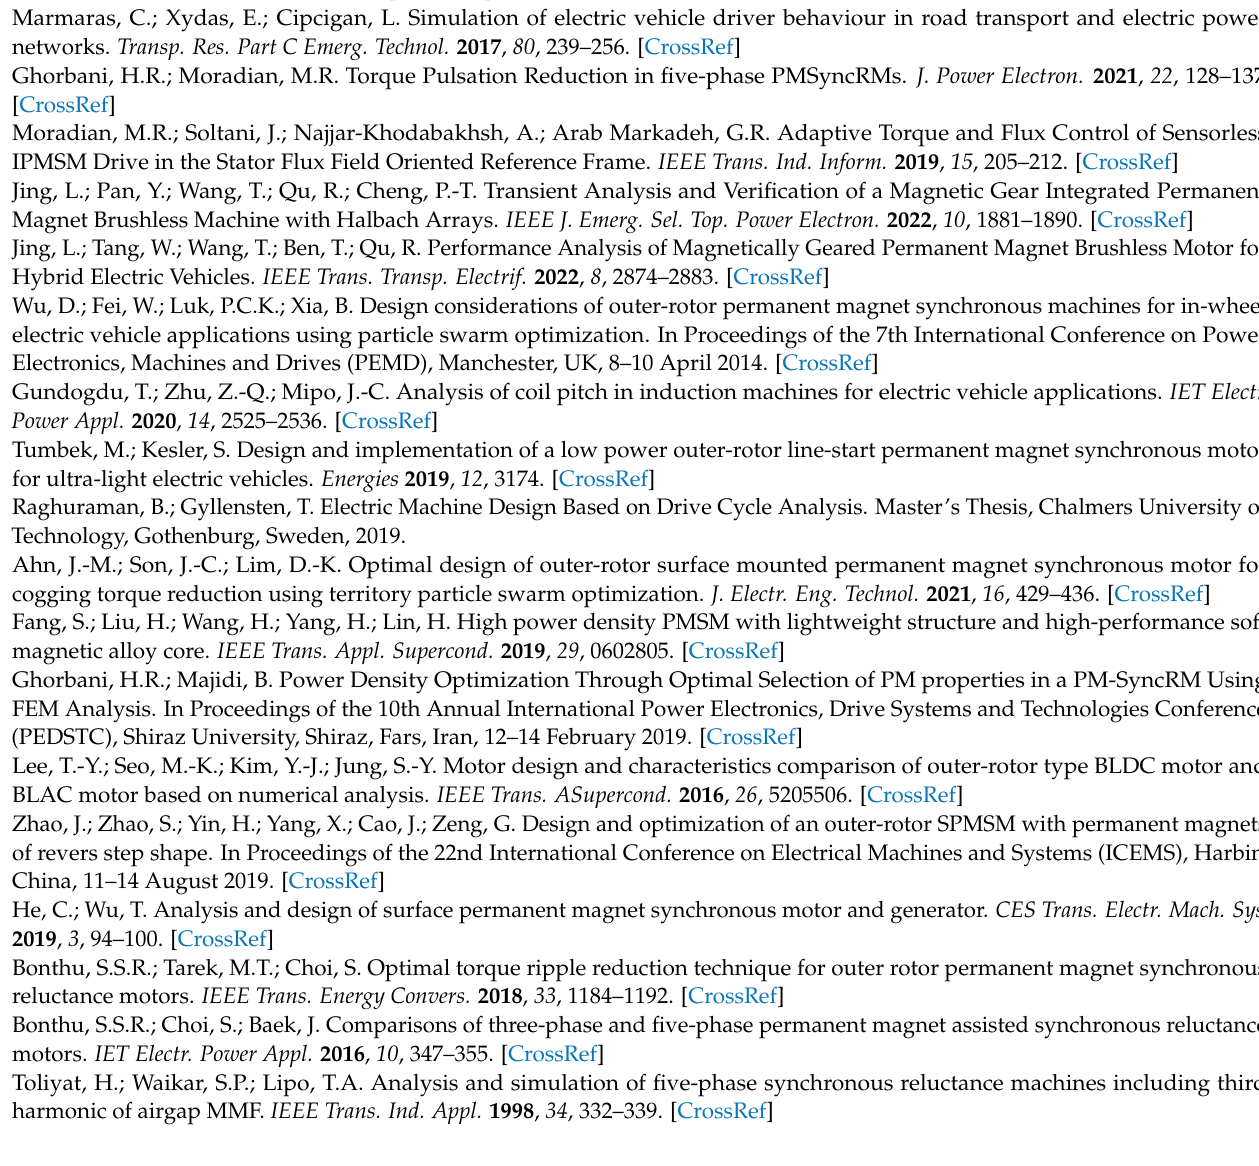
Figure A2. Flux density distribution in the optimized models: ( a ) Model-I, ( b ) Model-II, ( c ) Model- III.